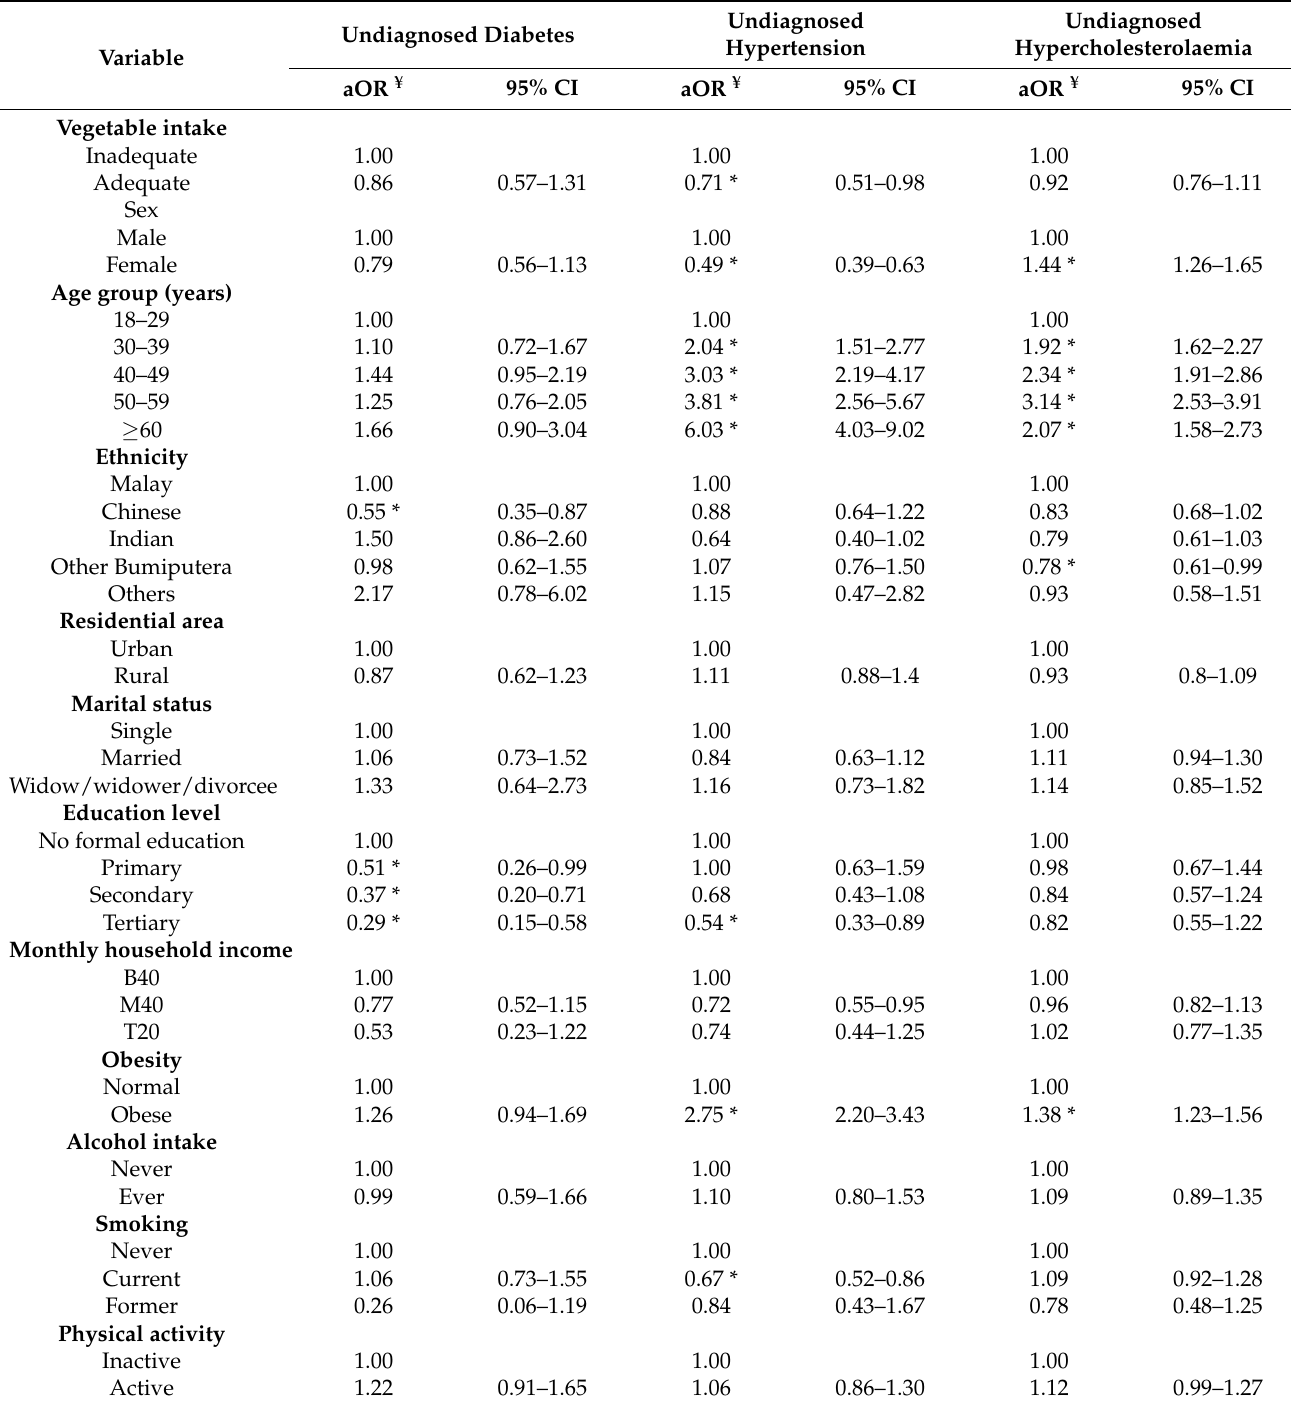
Table 4. Associations between adequate vegetable intake only and undiagnosed diabetes, undi- agnosed hypertension, and undiagnosed hypercholesterolemia in Malaysian adults aged 18 years and